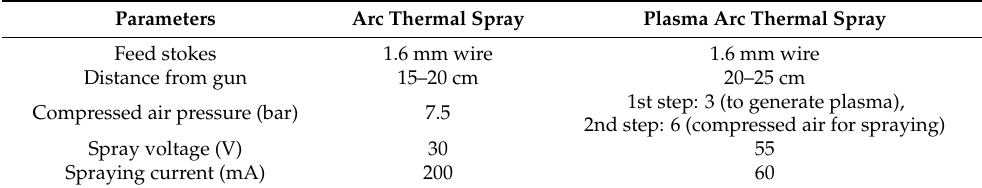
Table 1. Parameters of deposition of the Zn coating using the arc thermal spray and plasma arc thermal spray coating